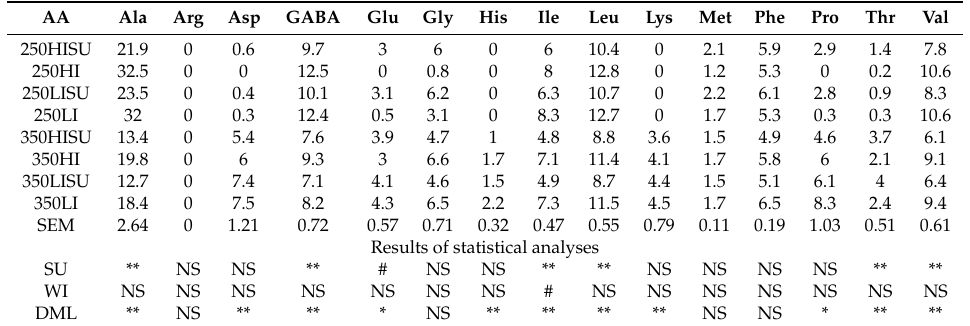
Table 4. Effect of sucrose addition (SU), wilting intensity (WI), and dry matter (DM) level (DML) on contents (g kg − 1 DM) of free amino acids (AA) and gamma-aminobutyric acid (GABA) in lucerne